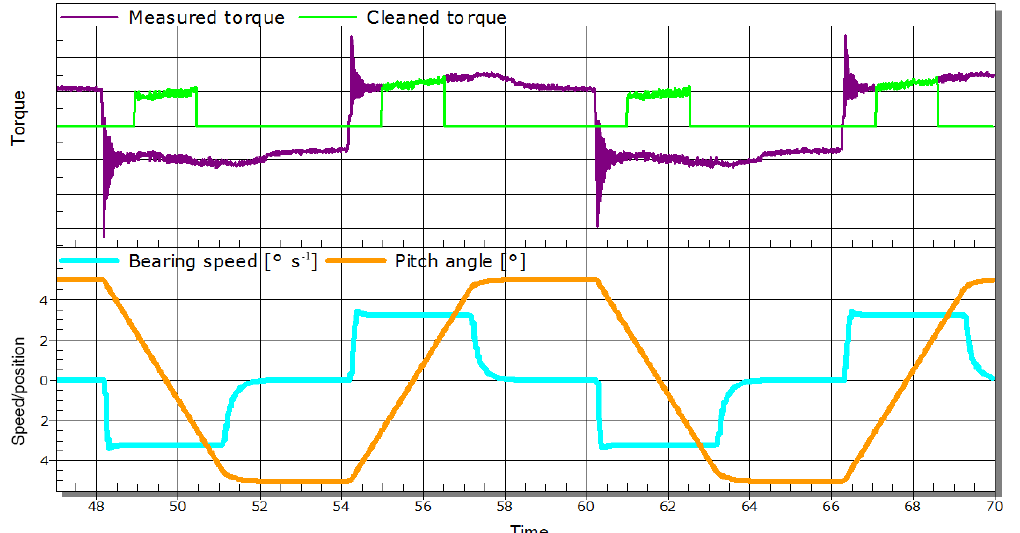
Figure 4. Oscillating rotations and torque measurements